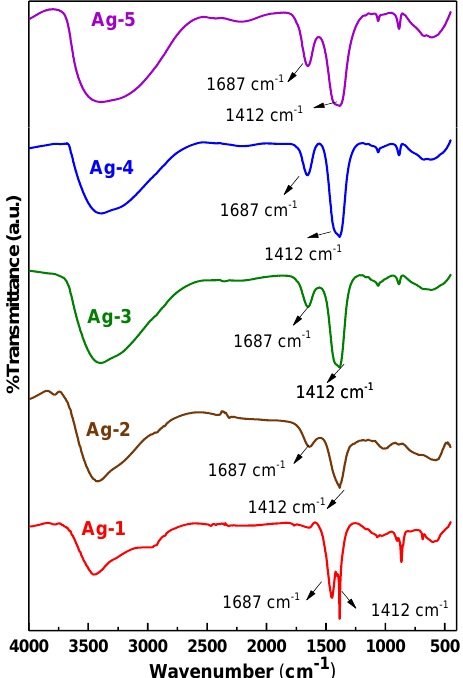
Figure 3. FT – IR spectra of synthesized Ag-containing nanomaterials . Figure 3. FT–IR spectra of synthesized Ag-containing nanomaterials.